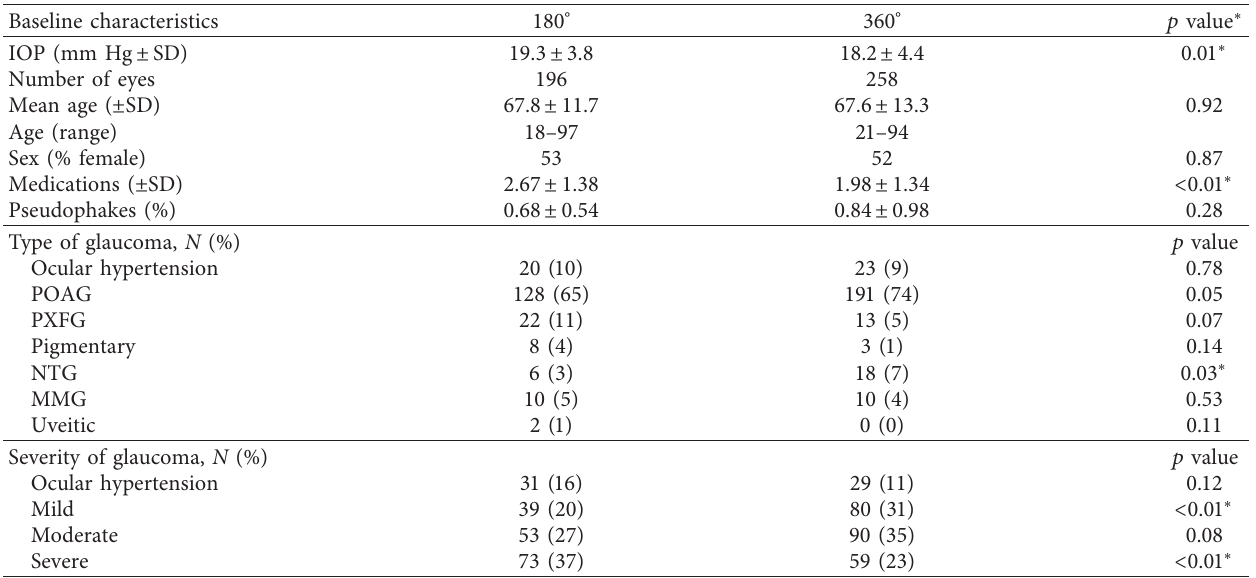
Table 2: Baseline characteristics.